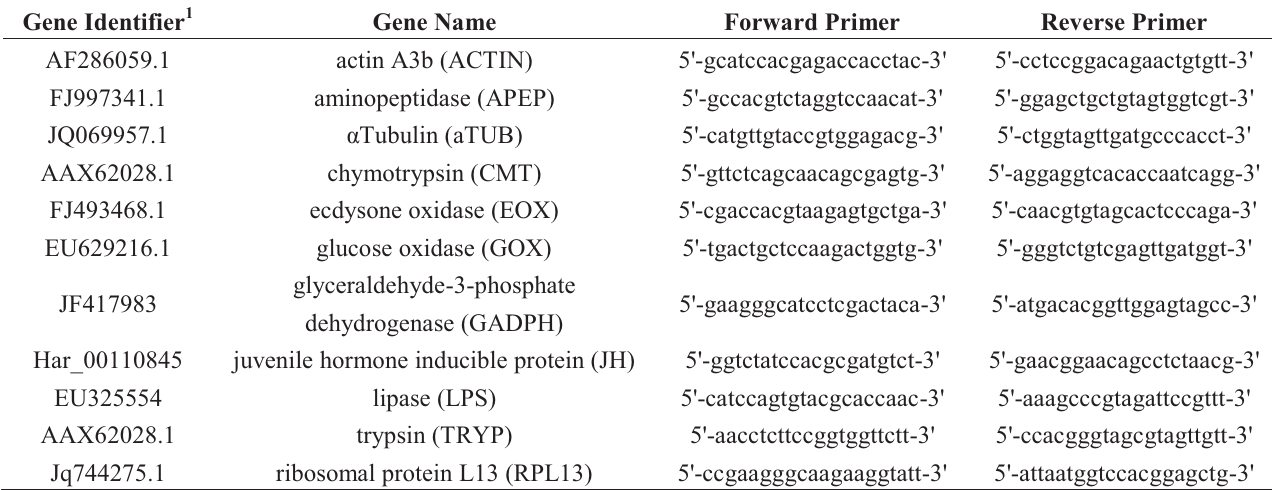
Table 1. Primers designed to verify gene